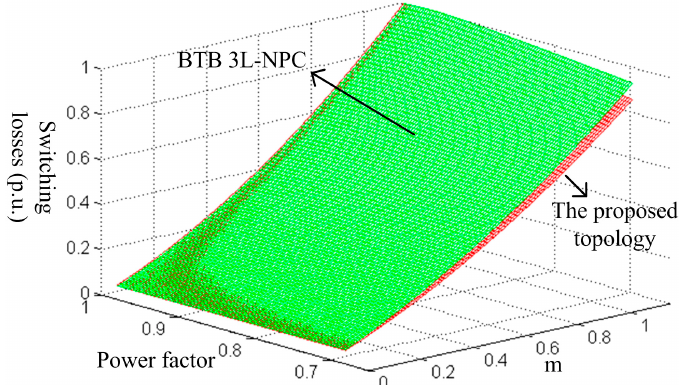
Figure 2. Switching losses comparison.